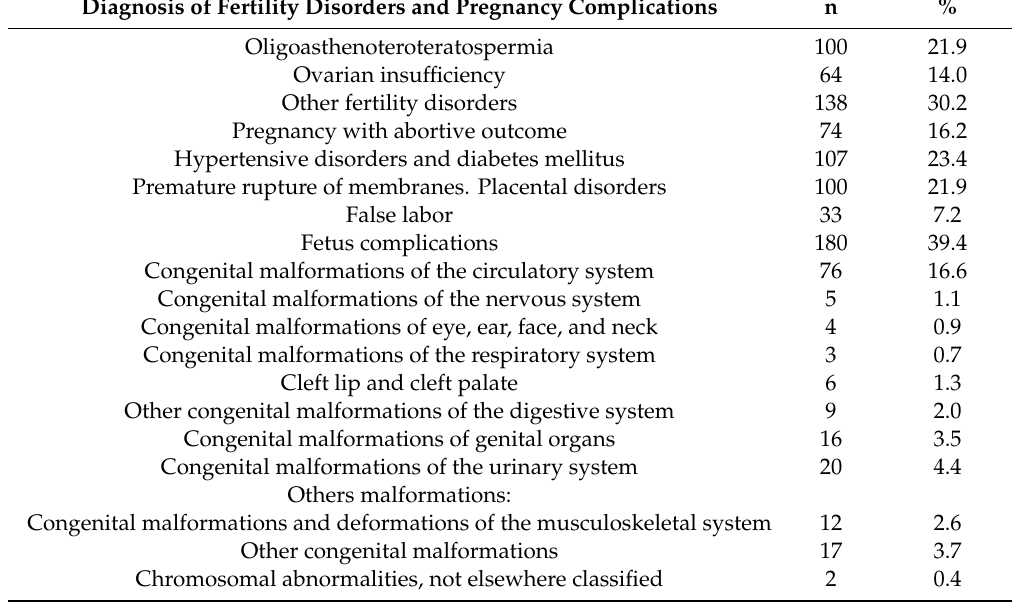
Table 2. Diagnosis of fertility disorders and pregnancy complications of patients seen at the ARTEMIS center from 16 February 2016 to 2 May 2019 (n = 457).